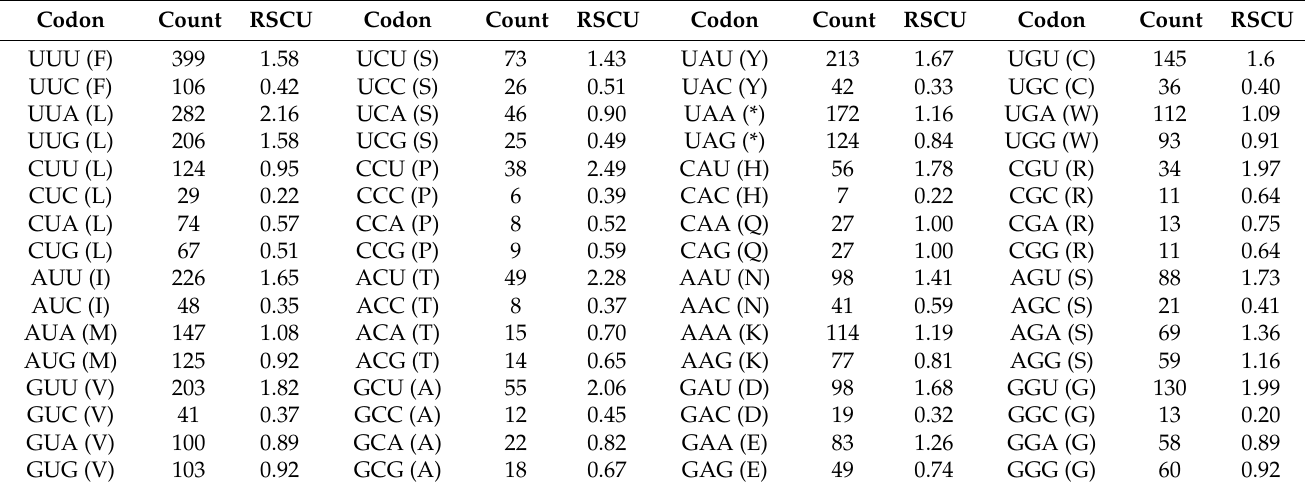
Table 3. The codon number and relative synonymous codon usage in the mitochondrial genomes of M. virgata . The asterisk (*) in the table indicates the stop